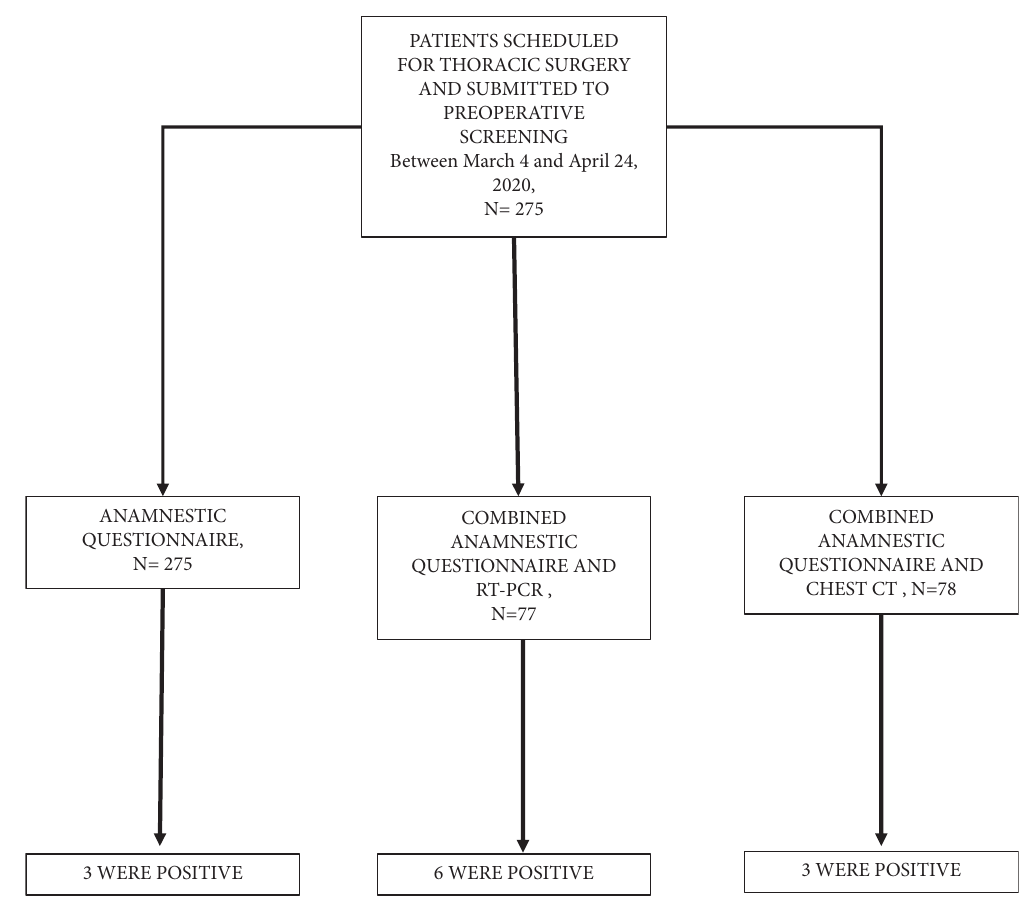
Figure 1: Study fowchart. CT, computed tomography; RT-PCR, reverse transcriptase polymerase chain Table 2: Clinical characteristics of patients undergoing preoperative screening.